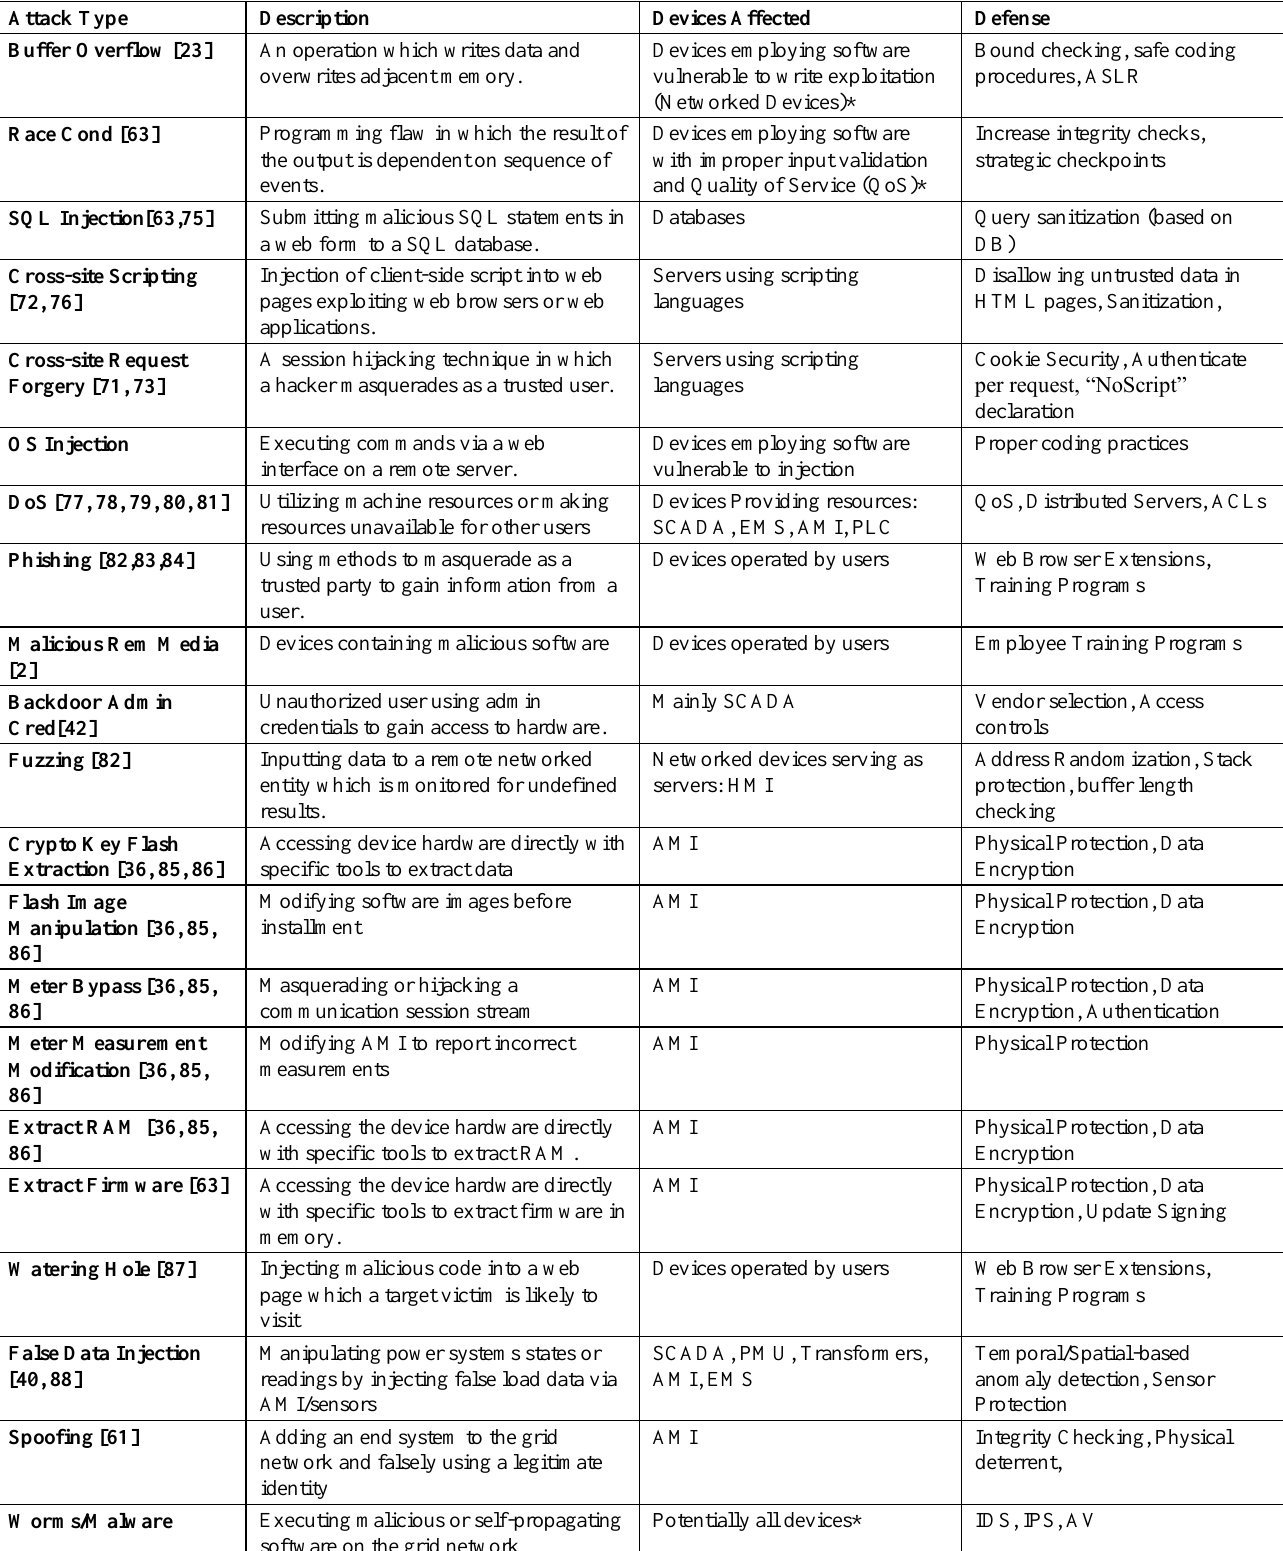
Table 4: methods to exploit software vulnerability. Hardware employing software with specific vulnerability may include: SCADA, HMI, PMU, AMI, Protective Relays, PLC,